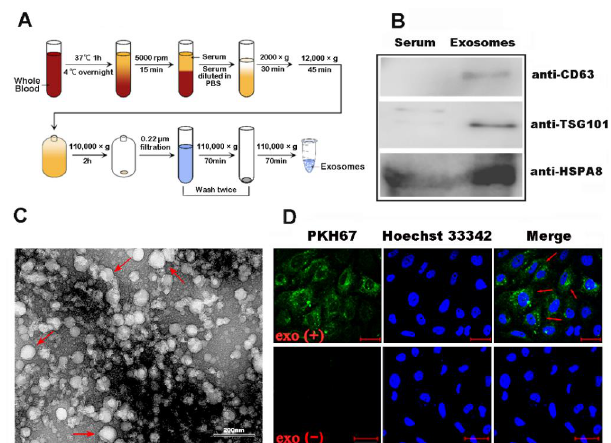
Figure 1. Isolated exosomes from mandarin fish serum. ( A ) Schematic of the generation of purified serum-derived exosomes from mandarin fish by using differential centrifugation. ( B ) Purified exo- somes (right) from mandarin fish serum were analyzed using Western blot with antibody directed against CD63, TSG101, and HspA8. The normal untreated mandarin fish serum (left) was used as the control. ( C ) Transmission electron microscopy observations of the purified exosomes from se- rum. ( D ) Confocal microscopy assay showed that the exosomes were internalized by MFF-1 cells after incubation with PKH67-labeled exosomes for 2 h.